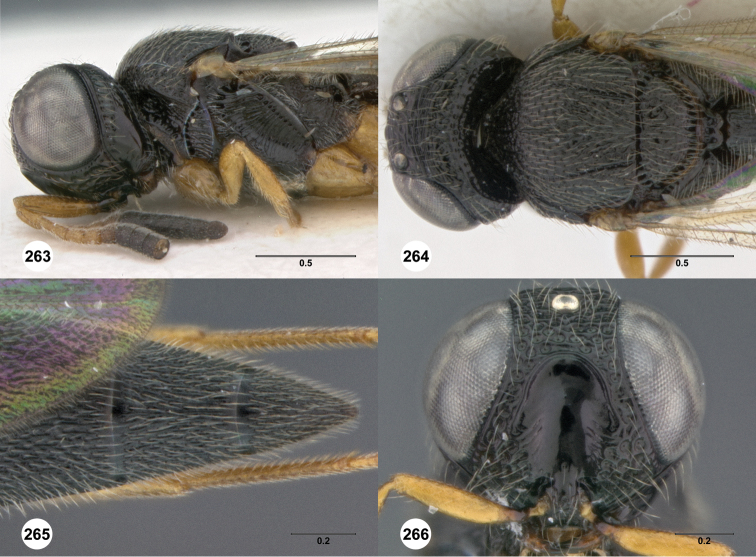
Oxyscelio proceritatis sp. n., holotype female (OSUC 368221) 263 Head and mesosoma, lateral view 264 Head and mesosoma, dorsal view 265 Metasoma, dorsal view. Paratype female (OSUC 462572) 266 Head, anterior view. Morphbank78